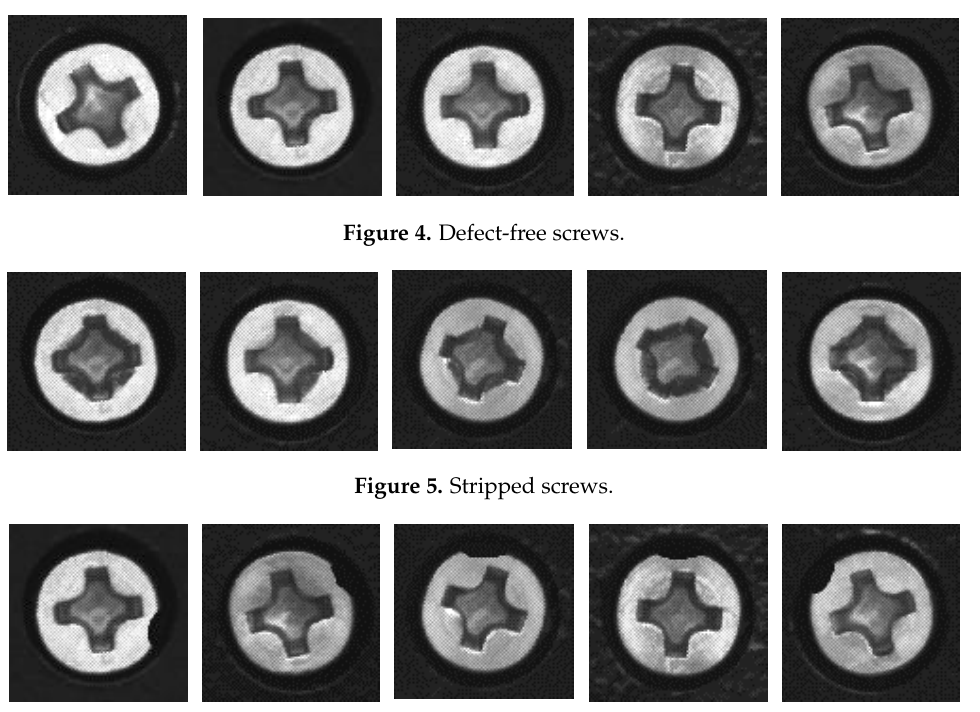
Figure 3. Data enhancement. ( a ) Original image, ( b ) image obtained by adjusting the light intensity, ( c ) rotated image, ( d ) distorted image.